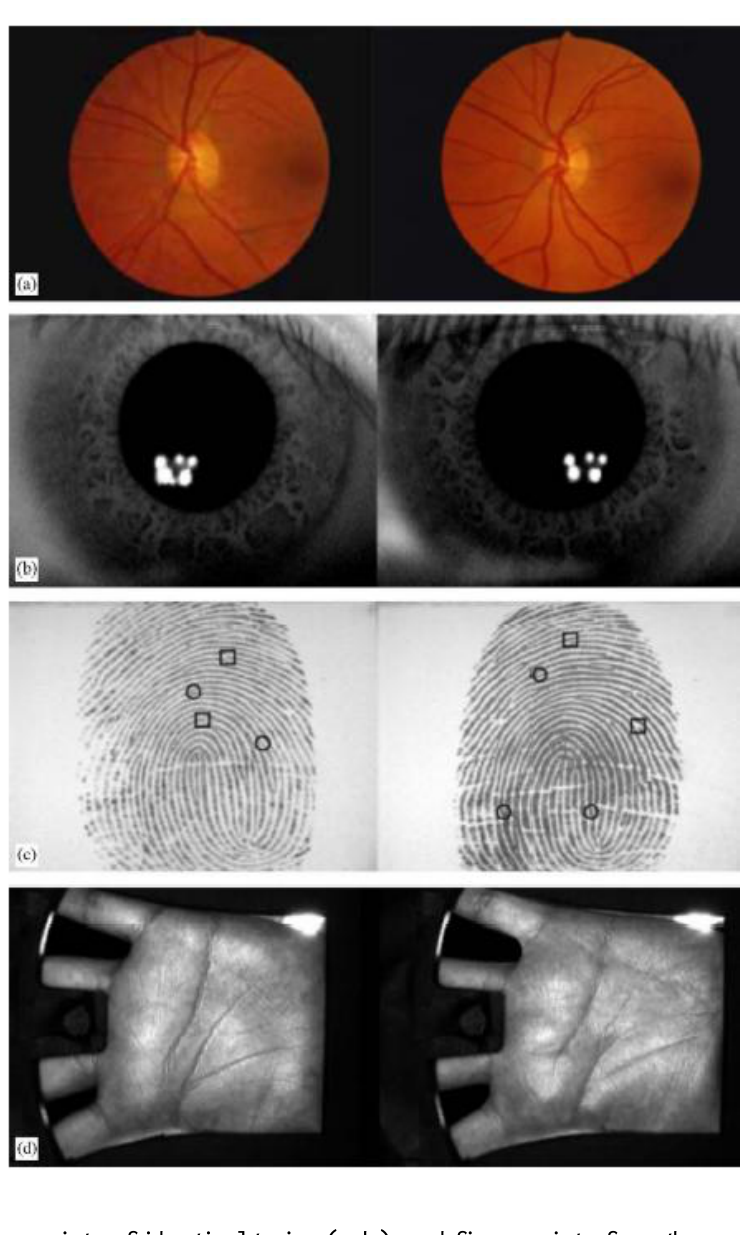
Figure 6. Different biometric features of identical twins [45]. (a) Retina, (b) Iris, (c) Fingerprint and (d) Palm print.